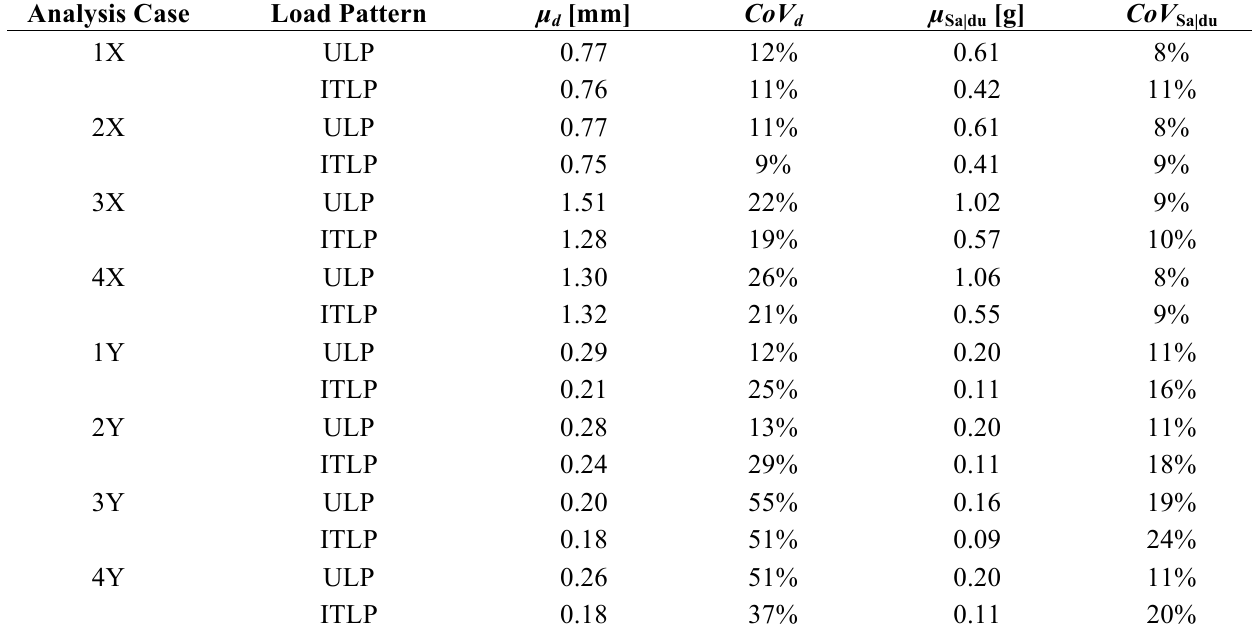
Table 2. Statistics of displacement capacity and conditional spectral